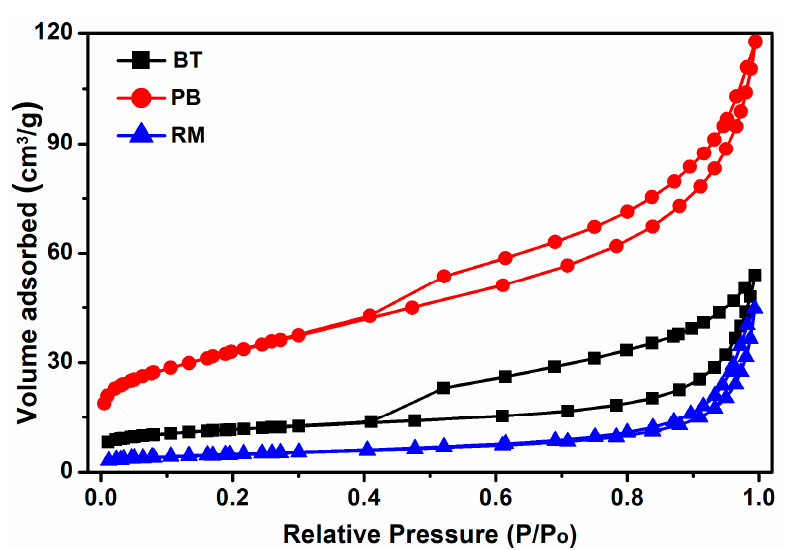
Figure 6. Brunauer–Emmett–Teller (BET) N 2 adsorption-desorption isotherms plot of the NICs sorbent. Table 2. Surface and pore characteristics of the NICs adsorbents.